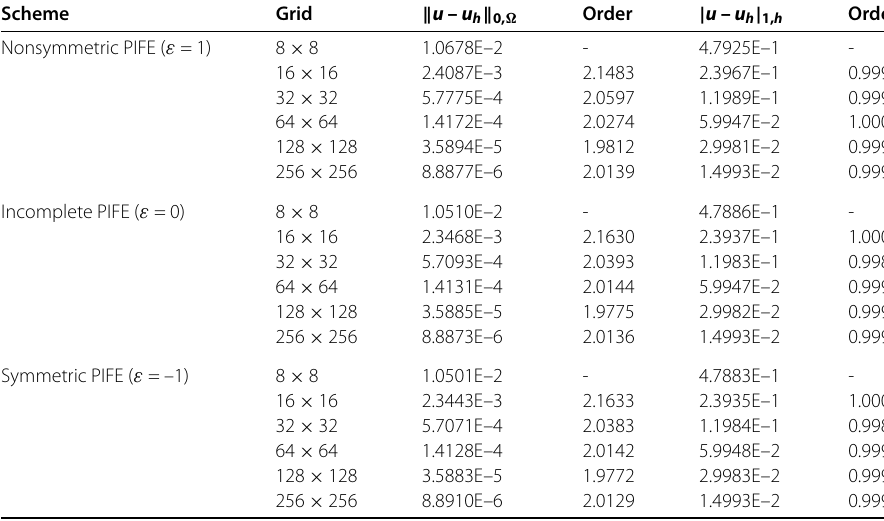
Table 2 Numerical results for ( β – , β + ) = (1,000,1) with different PIFE schemes